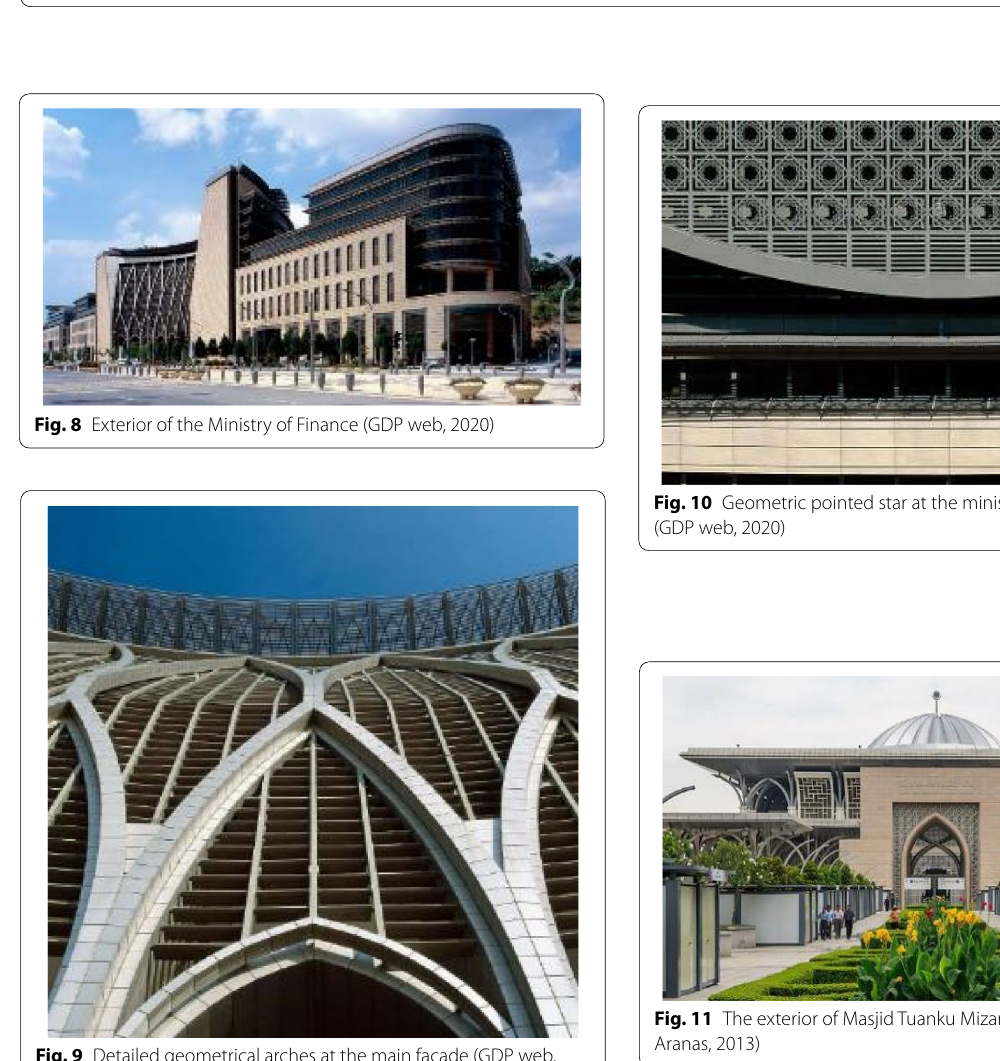
Fig. 7 Floral and geometric integration at the interior and exterior decoration (Erin Tracy 2019)